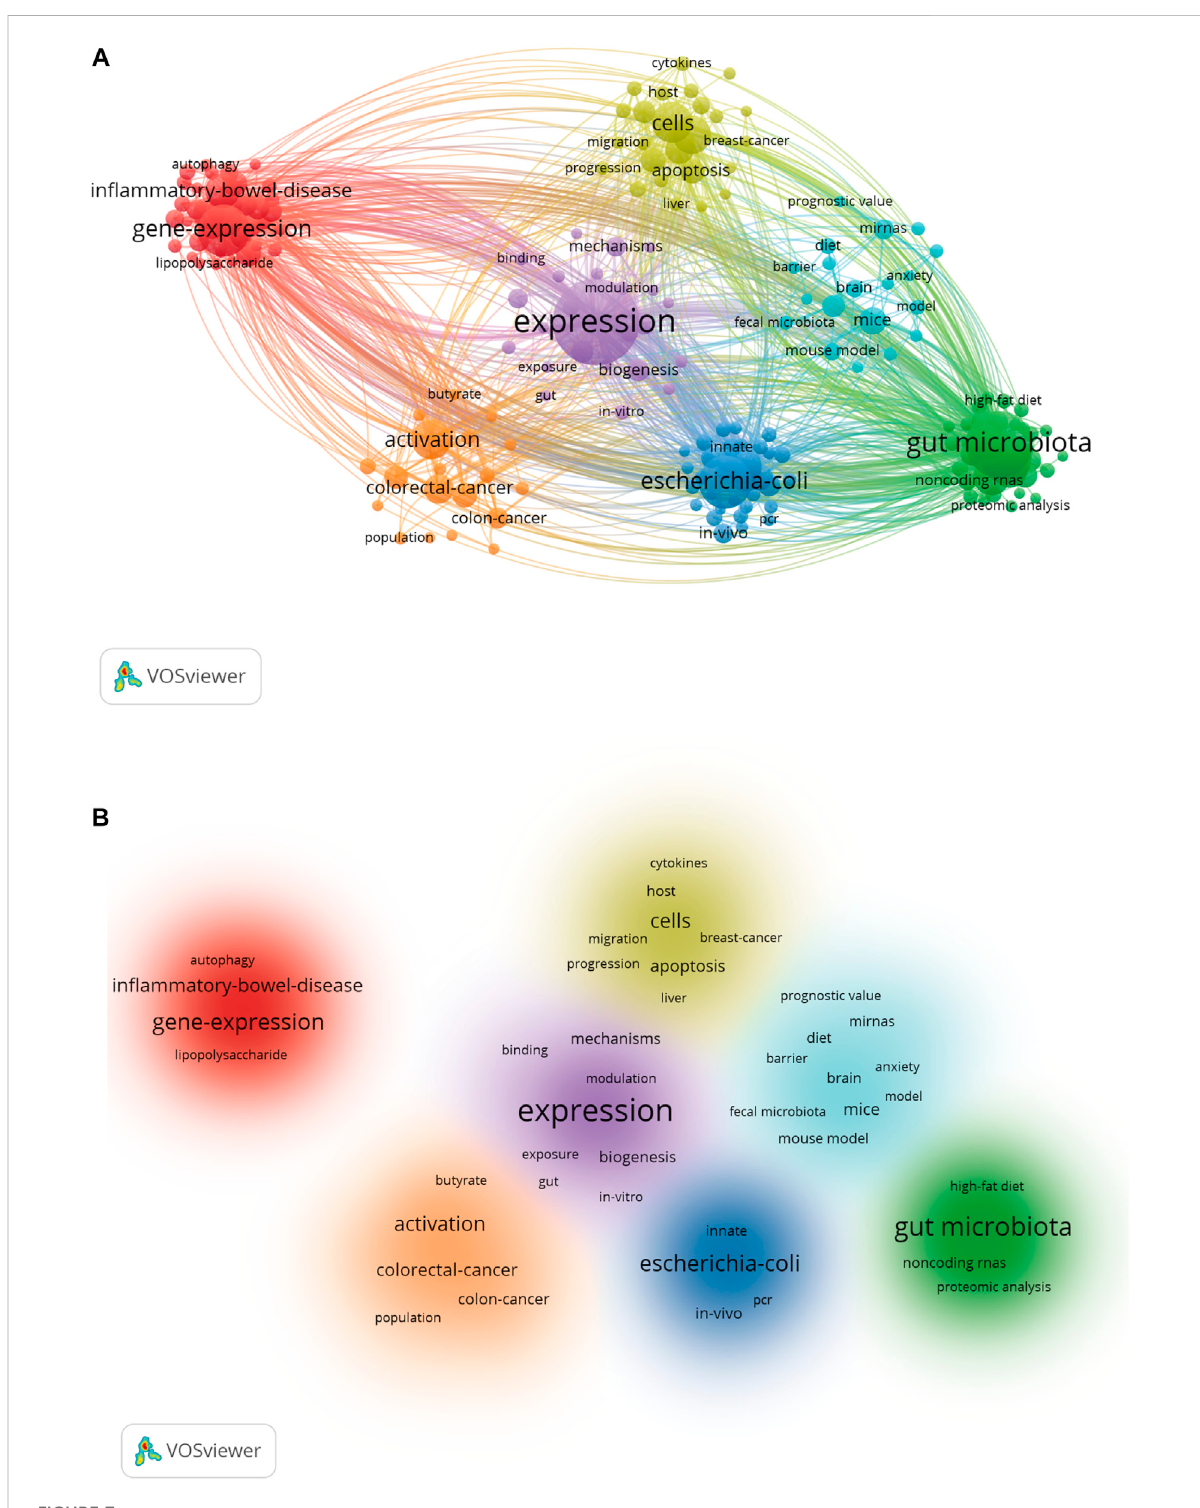
FIGURE 7 Keyword co-occurrence and cluster analysis. (A) VOSviewer ’ s network analysis of keywords. Distribution of keywords according to the mean frequency of appearance. (B) The clustering map based on occurrence analysis was divided into seven